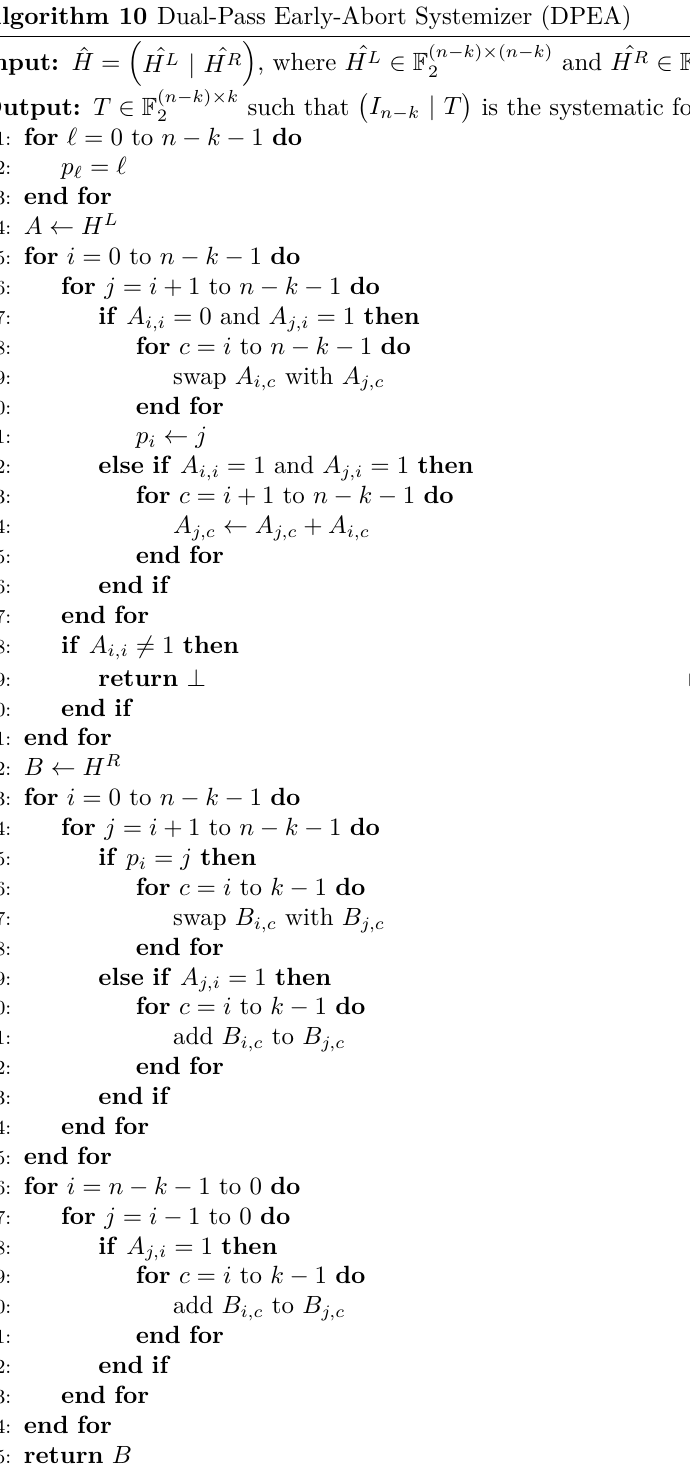
Algorithm 10 Dual-Pass Early-Abort Systemizer